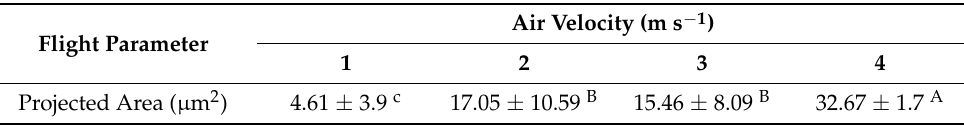
Table 1. Effect of air velocity at the outlet of the ducts of the designed ultrasonic humidifier on mean measured values of droplets projected under RH of 80% and temperature of 5 ◦ C.